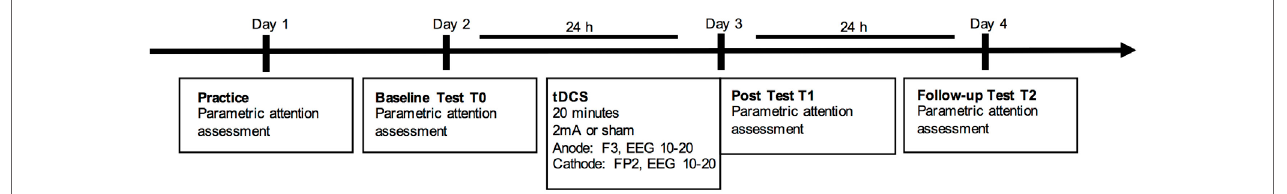
FiGUrE 1 | Flow-chart of the